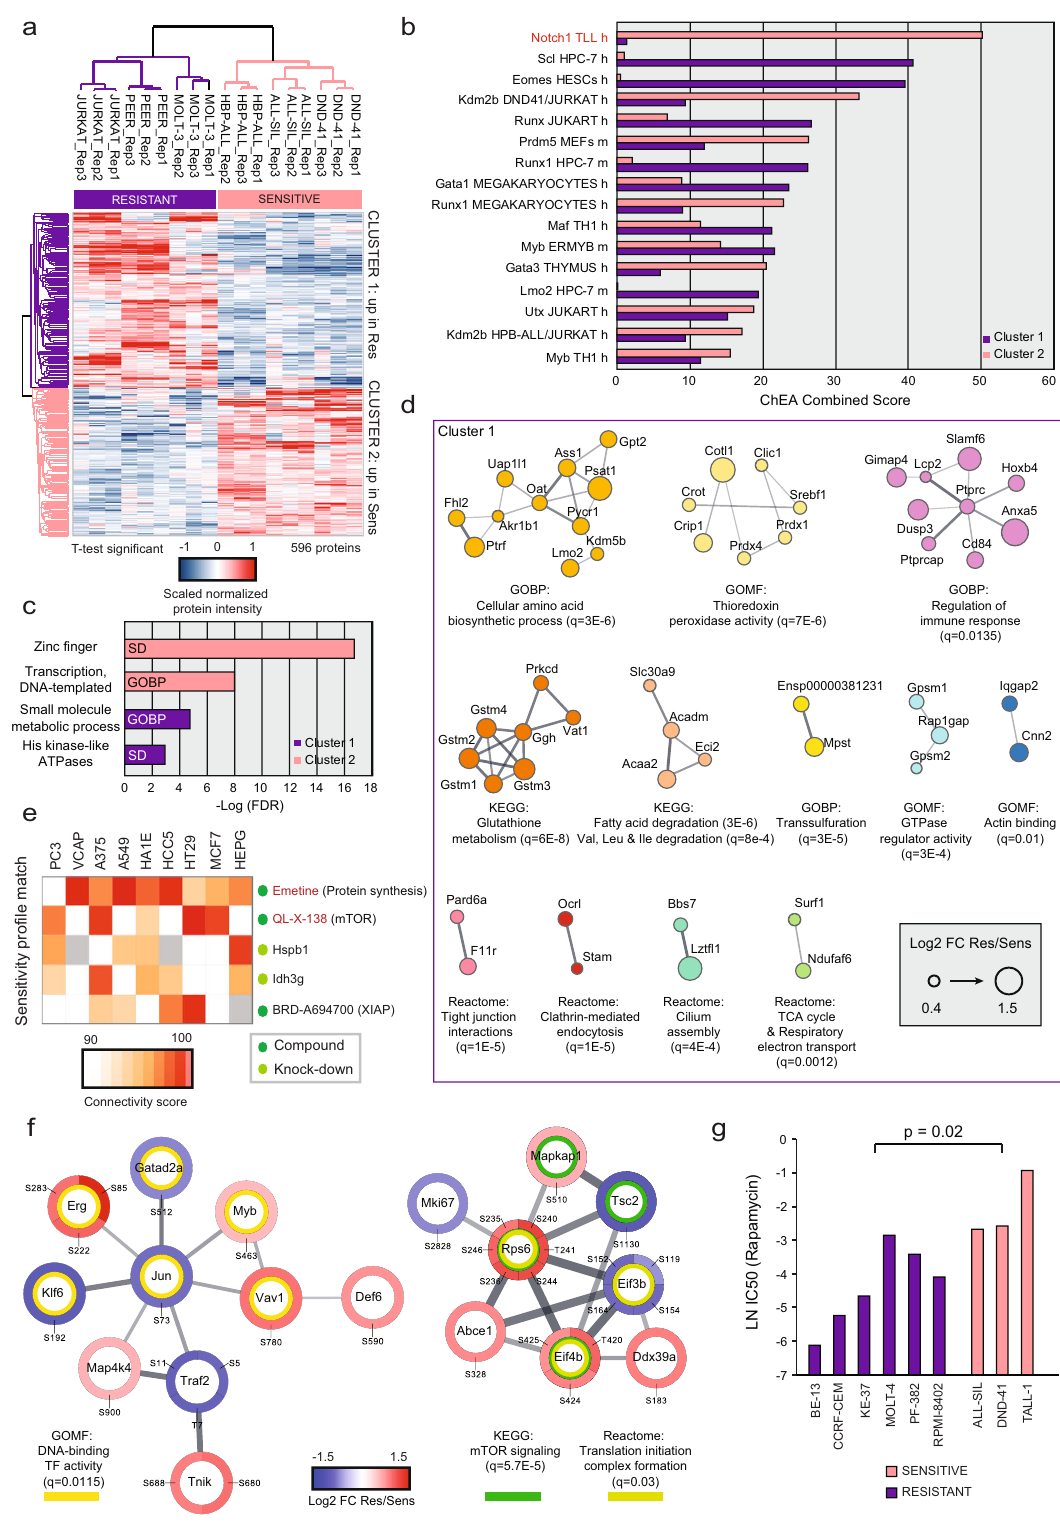
Reactome: Translation initiation complex formation (q=0.03)-1.5